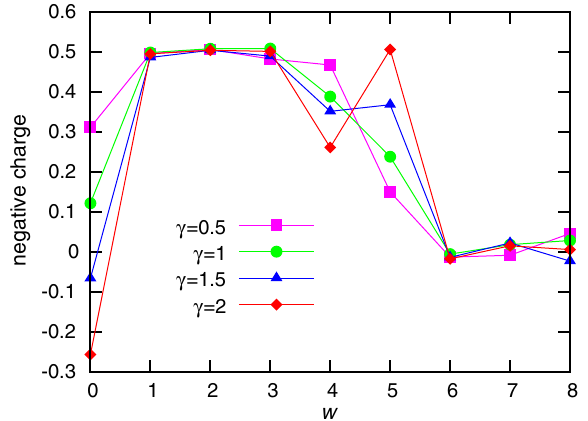
FIG. 9. Witten effect for different values of γ , but all other parameters the same as in Fig. 8. We see that near w ¼ 2 , when we are measuring the charge inside a sphere that surrounds exactly one monopole, the amount of charge is approximately one-half, and independent of γ . At smaller w (or at w ≳ 4 when the sphere starts overlapping with the screening cloud near the second monopole), the enclosed charge does depend on γ .